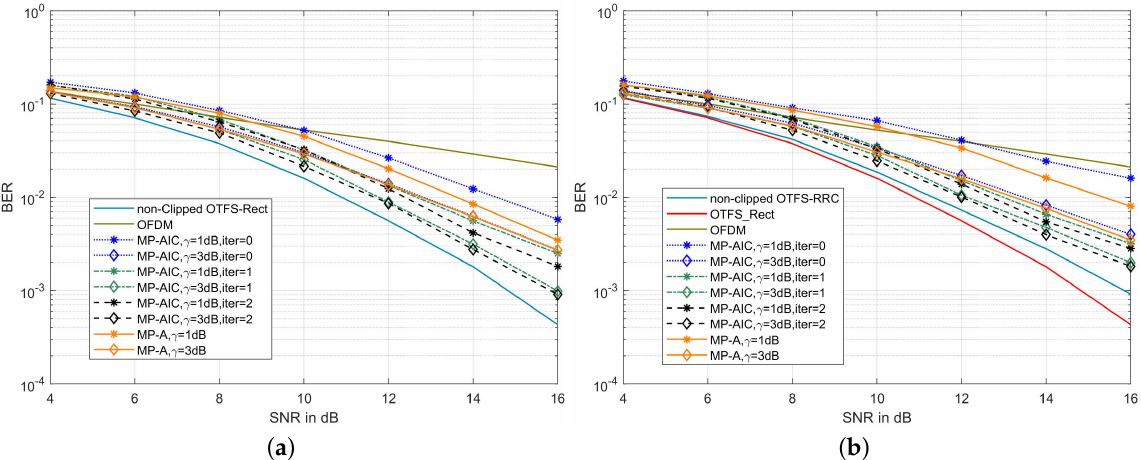
Figure 7. ( a ) BER comparison of the proposed MP-AIC method and MP-A [26] method in the clipped OTFS-Rect system on the channel with a maximum Doppler shift of 1935.48 Hz; ( b ) BER comparison of the proposed MP-AIC method and MP-A [26] method in the clipped OTFS-RRC system on the channel with a maximum Doppler shift of 1935.48 Hz ( α = 0.1).